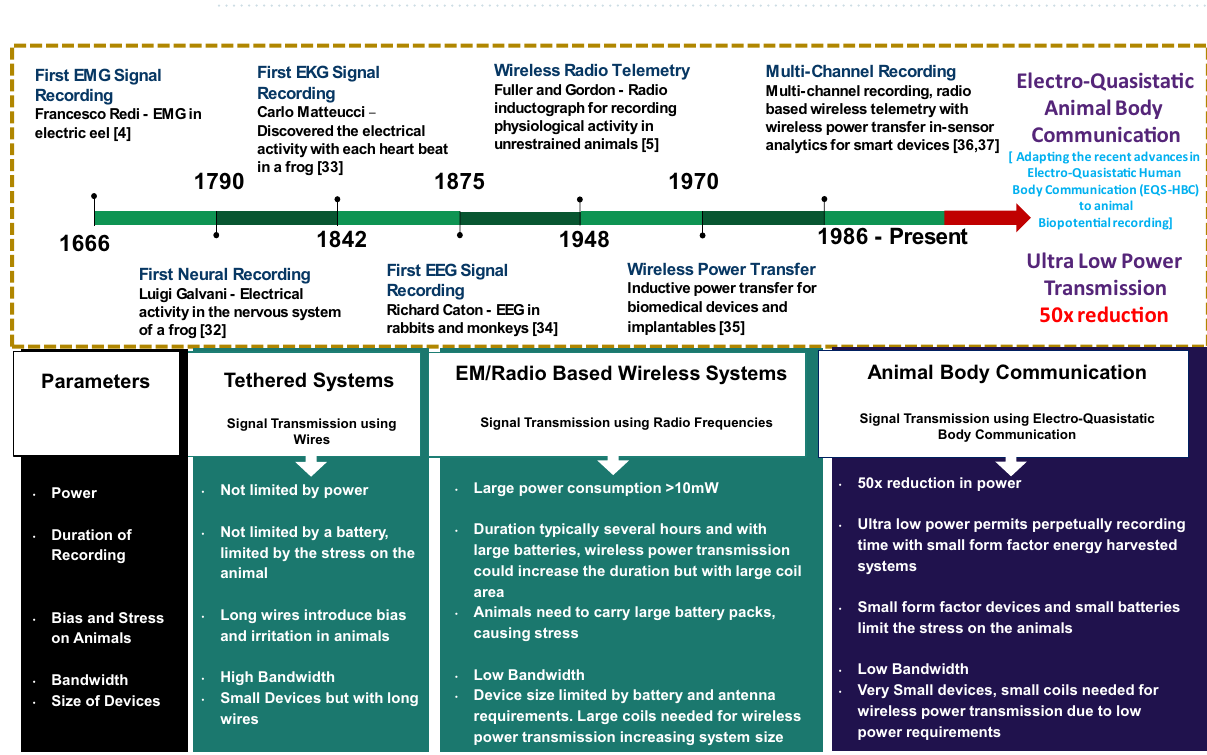
Figure 8. Effect of an External Ground Plane: ( a ) Experimental setup depicting the electric field lines from the transmitter ground plane to the external ground plane; Capacitive return path from the transmitter ground to the external ground plane. ( b ) In vivo test setup with a hand-held external ground plane. The external ground plane is placed above the rat body similar to the experimental setup, mirroring the top of a rat cage. The rat models in (a) were created using the software Paint 3D by Microsoft Corporation (Version 6.2009.30067.0).